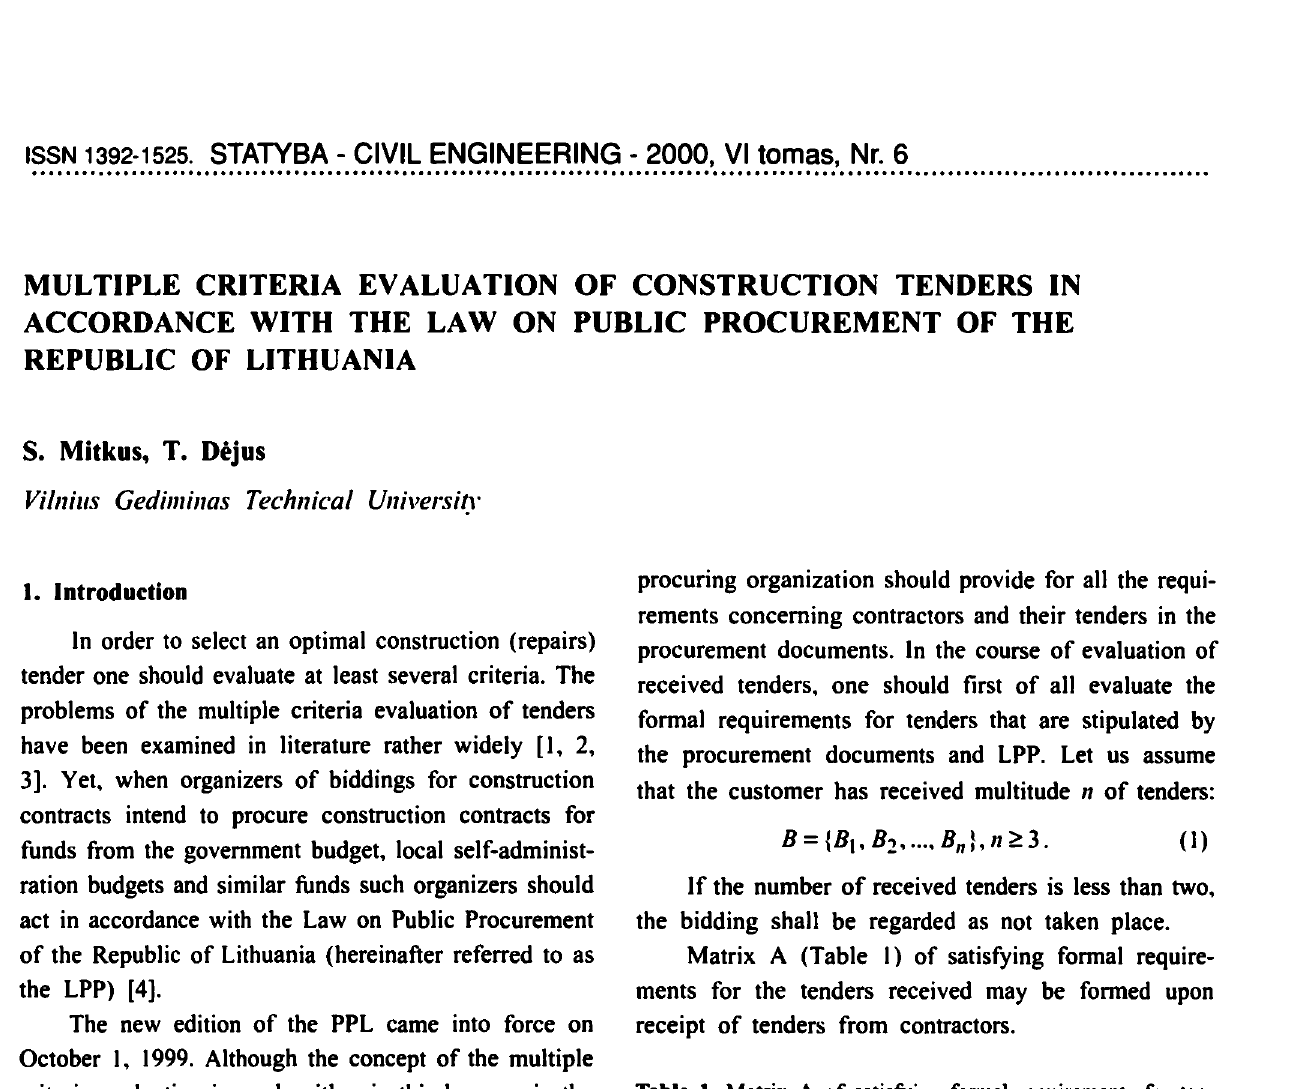
Table I. Matrix A of satisfying fonnal requirements for ten